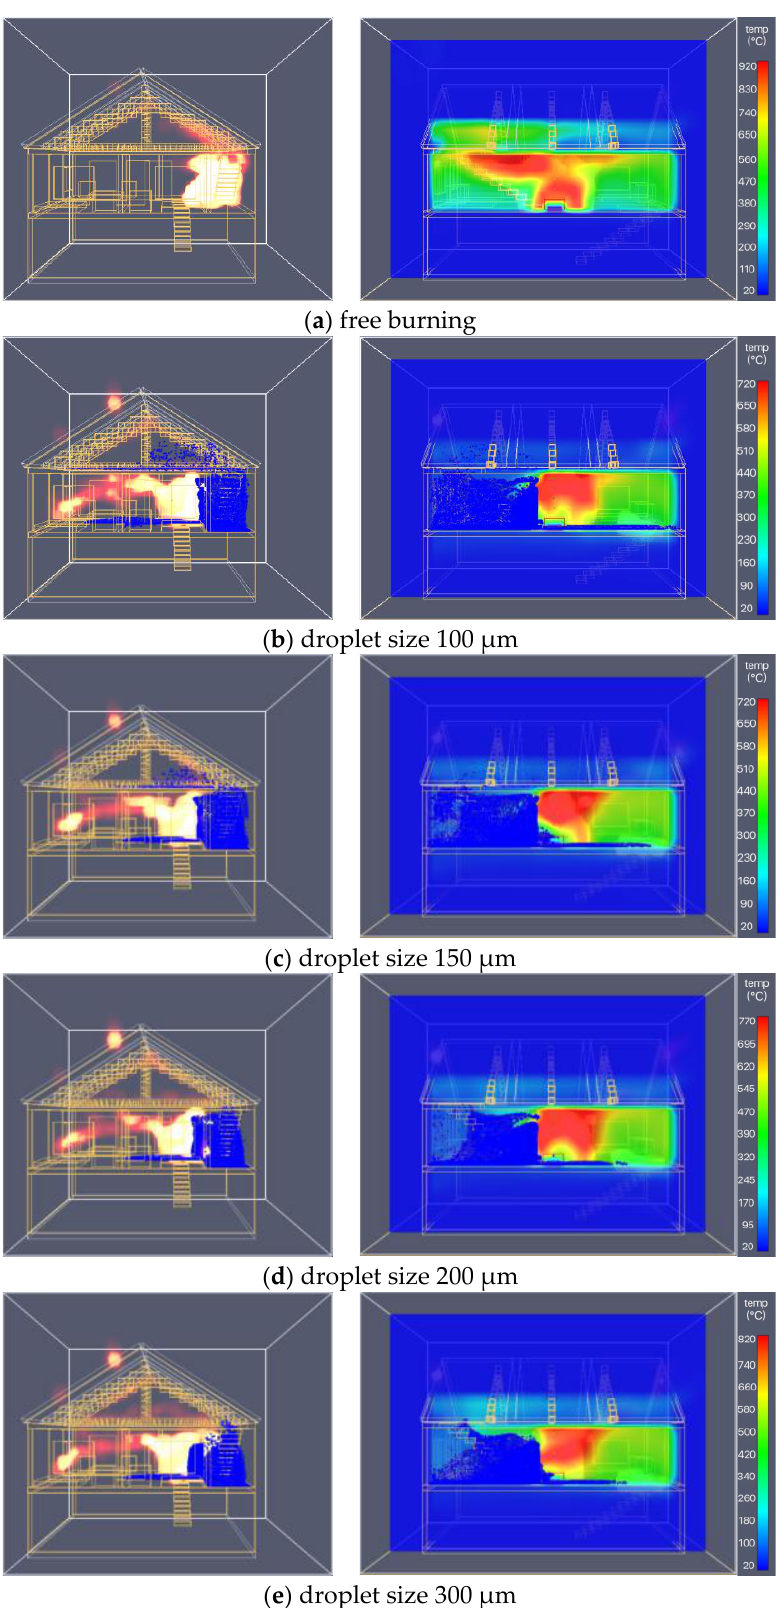
Figure 3. Temperature profiles of different droplet sizes at 480 s.